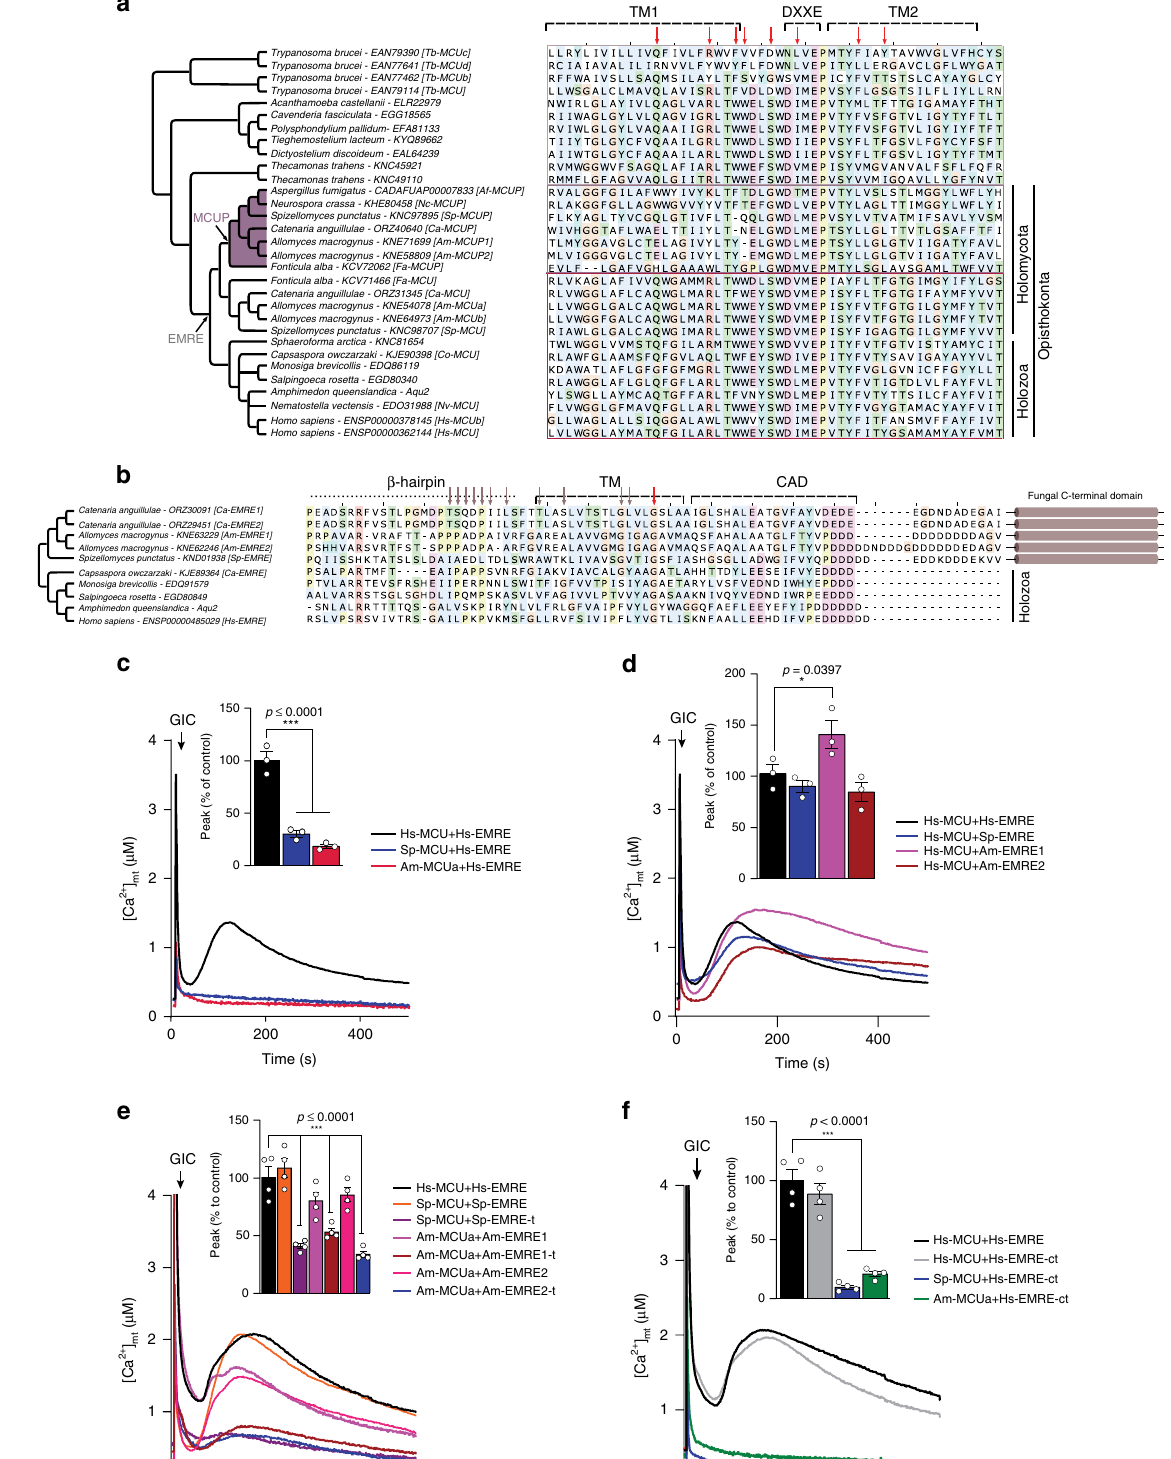
chytrid EMREs. These fi ndings indicate a tight co-evolution between MCU and EMRE proteins, which we know to func- tionally and physically interact, and provide the framework to understand the sequence determinants of this interaction.